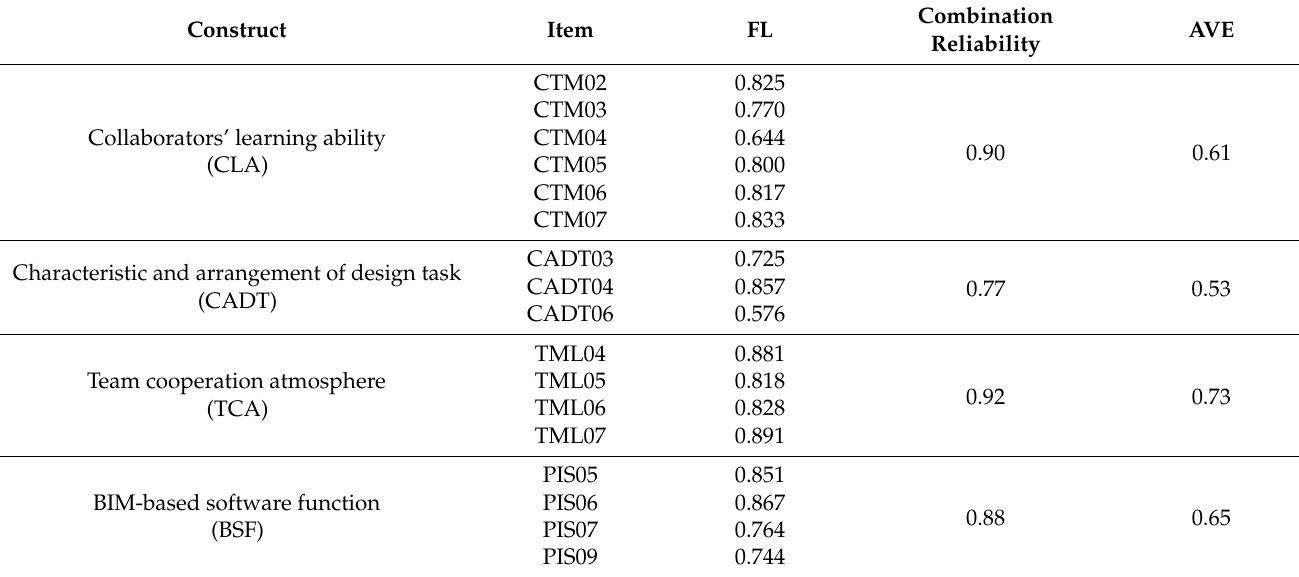
Table 4. Converged validity of the initial structural